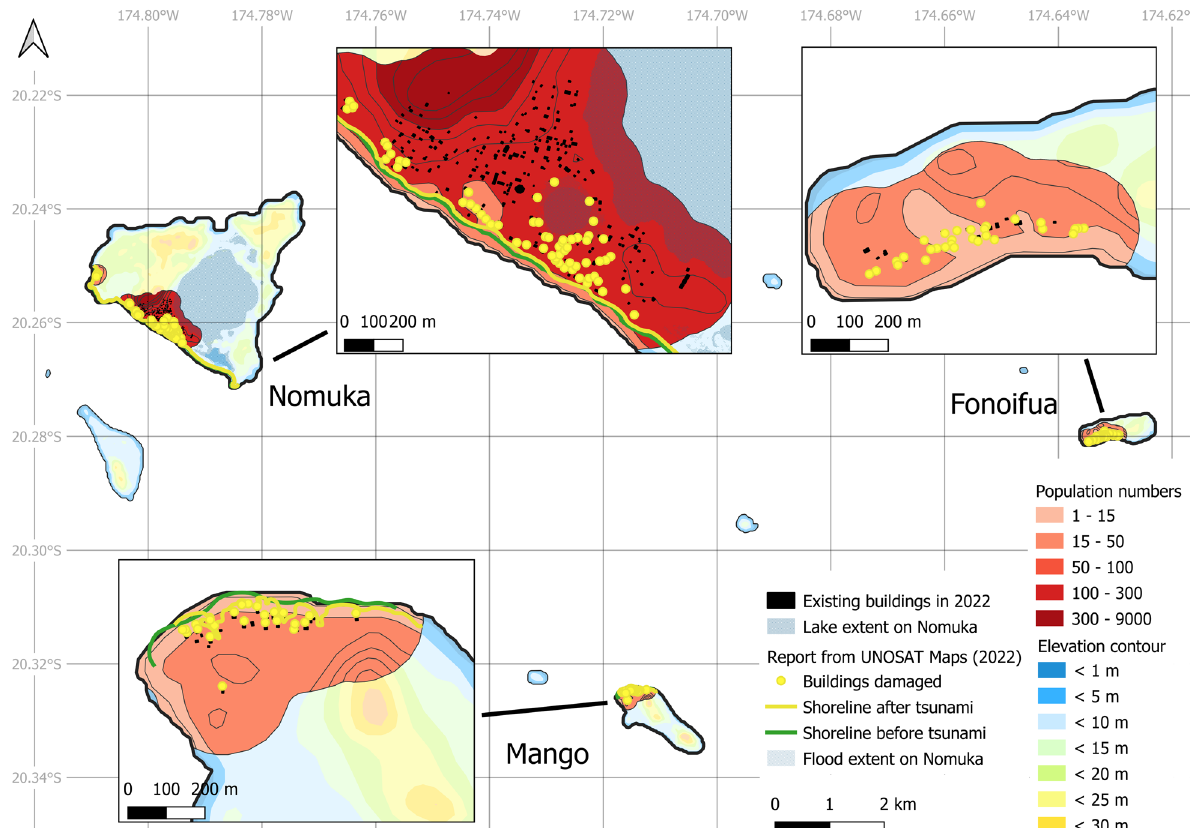
Fig. 8 Overview of buildings damaged by the 2022 tsunami on Nomuka, Mango and Fonoifua islands. Gray polygons: buildings included in this study (OCHA 2022c). Yellow dots: buildings confirmed damaged by UNOSAT Maps (2022). Green line: shoreline before the tsunami (GSHHG 2017). Yellow line: shoreline retreat after the tsunami by UNOSAT Maps